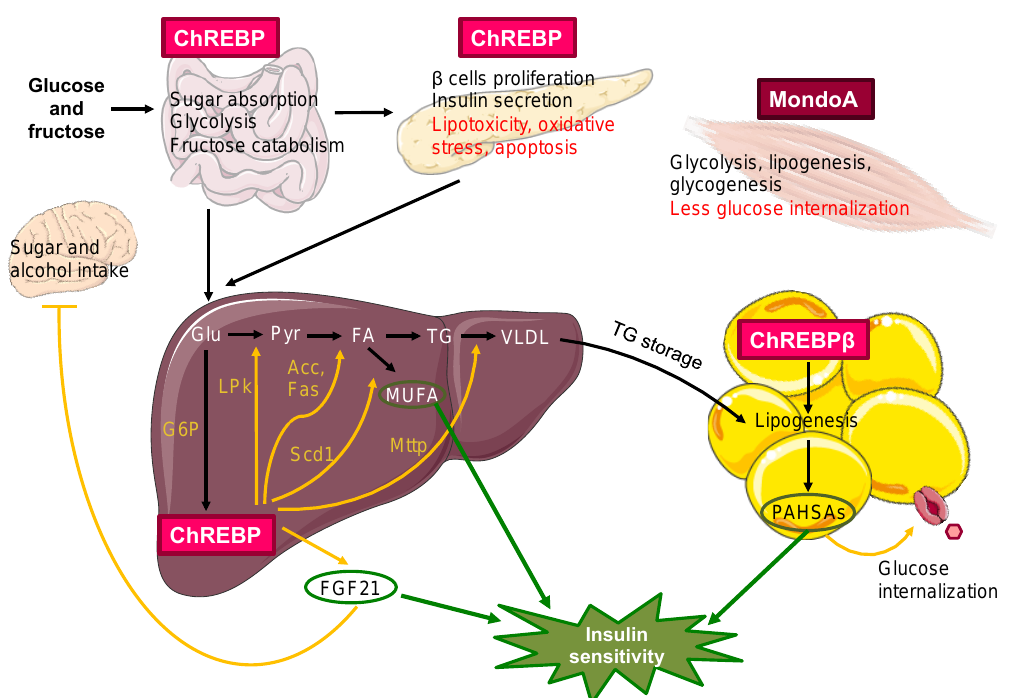
Figure 5. Metabolic functions of ChREBP/MondoA in the main organs and tissues. ChREBP is abundantly expressed in liver and adipose tissue, where it induces glycolysis and lipogenesis represented in the liver. It is also expressed in the intestine and pancreas, where its actions are indicated, highlighting in red the pathological ones. In the skeletal muscle, MondoA stands out. ChREBP promotes the expression of the metabolites MUFA, PAHSA and the hepatokine FGF21, and these are proposed to be responsible for the insulin sensitivity effect. Genes activated by ChREBP are shown in yellow. Pyr: pyruvate; TG: triglycerides. This figure was modified from [111], and created with Servier Medical Art (https://smart.servier.com/, accessed on 20 August 2020) under a creative commons license (https://creativecom- mons.org/licenses/by/3.0/).